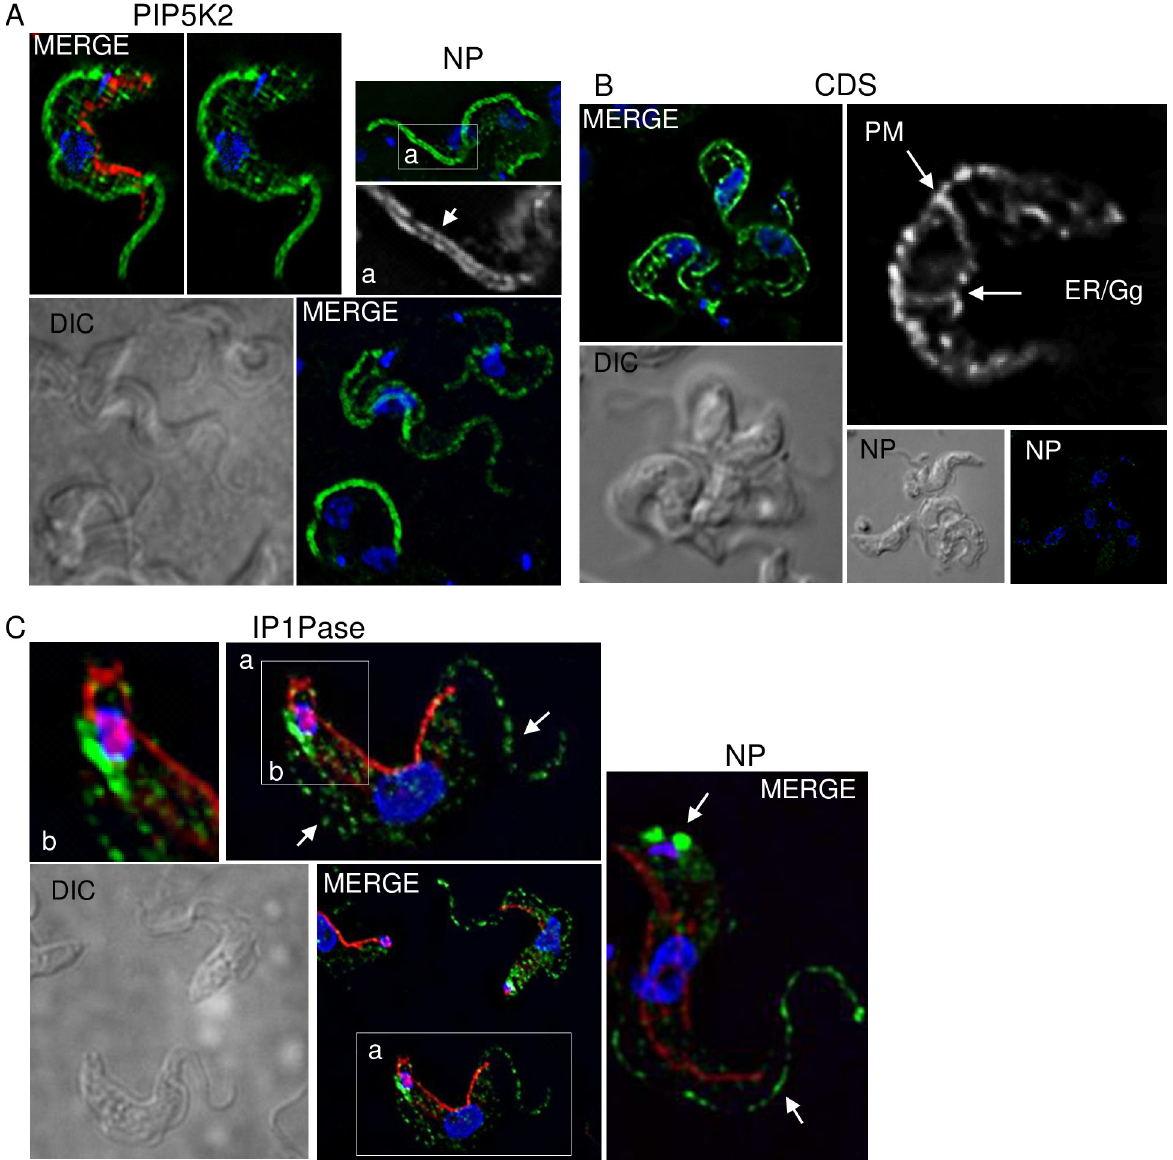
Fig 3. Subcellular immunofluorescence localization of PI enzymes in T . brucei slender BF. V5-tagged PIP5K2 (A), CDS (B), or IP1Pase (C) were expressed from rDNA locus upon induction with tetracycline and stained green with anti-V5 fluorescein-conjugated monoclonal antibodies. Mitochondria are stained red with mitoTracker, DNA is stained blue with DAPI, and DIC indicates differential interference contrast. Arrows indicate PI enzyme staining in black and white in expanded regions. The cells were permeabilized with 0.2% NP40 except as indicated as NP. BF, bloodstream form; CDS, CDP-diacylglycerol synthetase; DAPI, 4 0 ,6-diamidino-2-phenylindole; DIC, differential interference contrast; ER, endoplasmic reticulum; Gg, Golgi; IP1Pase, inositol polyphosphate 1-phosphatase; NP, non-permeabilized; PI, phosphatidylinositol; PIP5K2, phosphatidylinositol 4-phosphate 5-kinase 2; PM, plasma membrane.